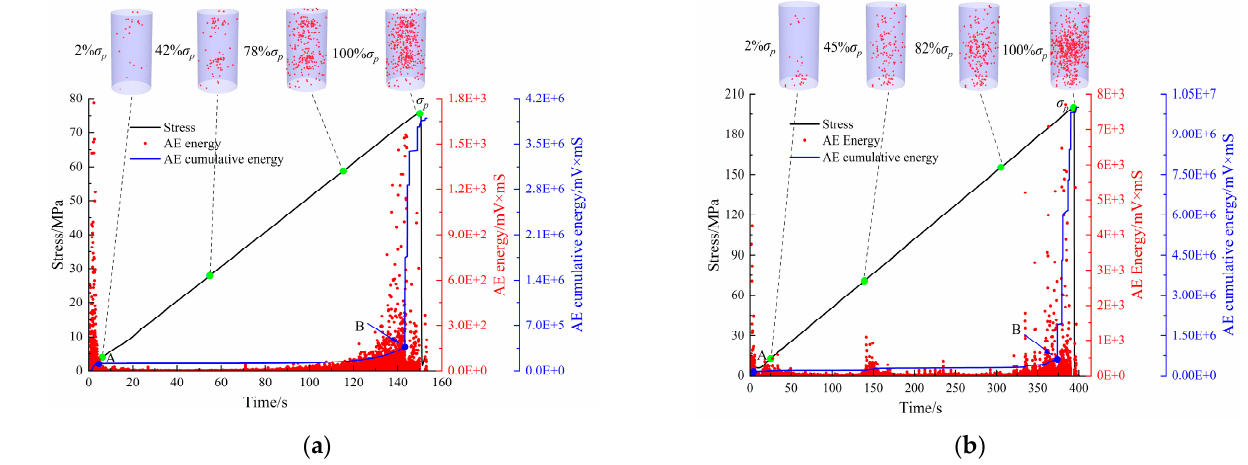
Figure 9. The AE energy evolution and location under UC. ( a ) Sandstone; ( b ) granite.